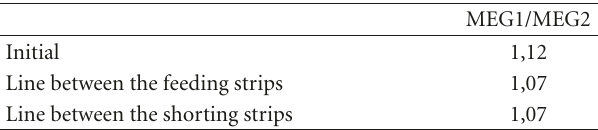
Table 1: Comparison of η and the MEG of both antennas of the di ff erent structures at f = 2 GHz. tot (dB) antenna1 MEG (dB) antenna1 η (dB) antenna2 MEG (dB) antenna2 η tot tot Sim. RC Sim. RC Sim. RC Sim. RC Initial − 0.816 − 0.75 − 3.826 − 3.75 − 0.81 − 1.25 − 3.826 − 4.25 Line between the − 0.10 − 0.2 − 3.11 − 3.2 − 0.09 − 0.5 − 3.108 − 3.5 feeding strips Line between the − 0.14 − 0.35 − 3.152 − 3.35 − 0.14 − 0.65 − 3.151 − 3.65 shorting strips